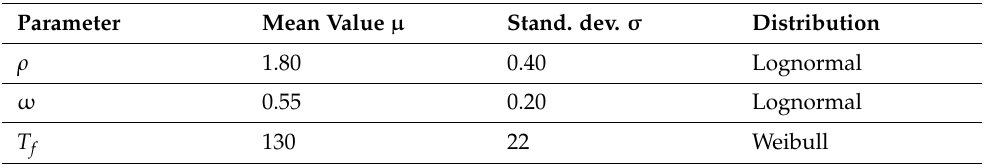
Table 2. Damage law parameters and their probability distributions governed by the means and standard deviations reported here. Parameter Mean Value µ Stand. dev. σ Distribution ρ 1.80 0.40 Lognormal 0.55 0.20 Lognormal